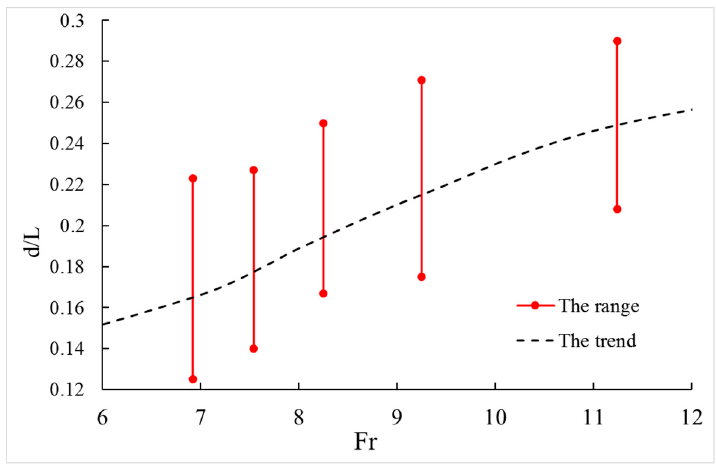
Figure 11. The range of the best depth of the stilling basin.